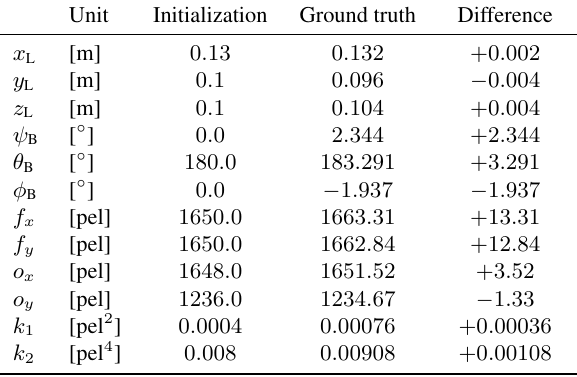
Table 2: This table shows the RMSE of the calibration